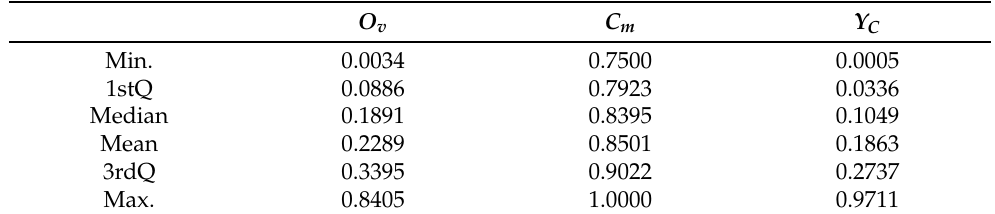
Table 3. Summary of similarity values with a C m over 0.75.